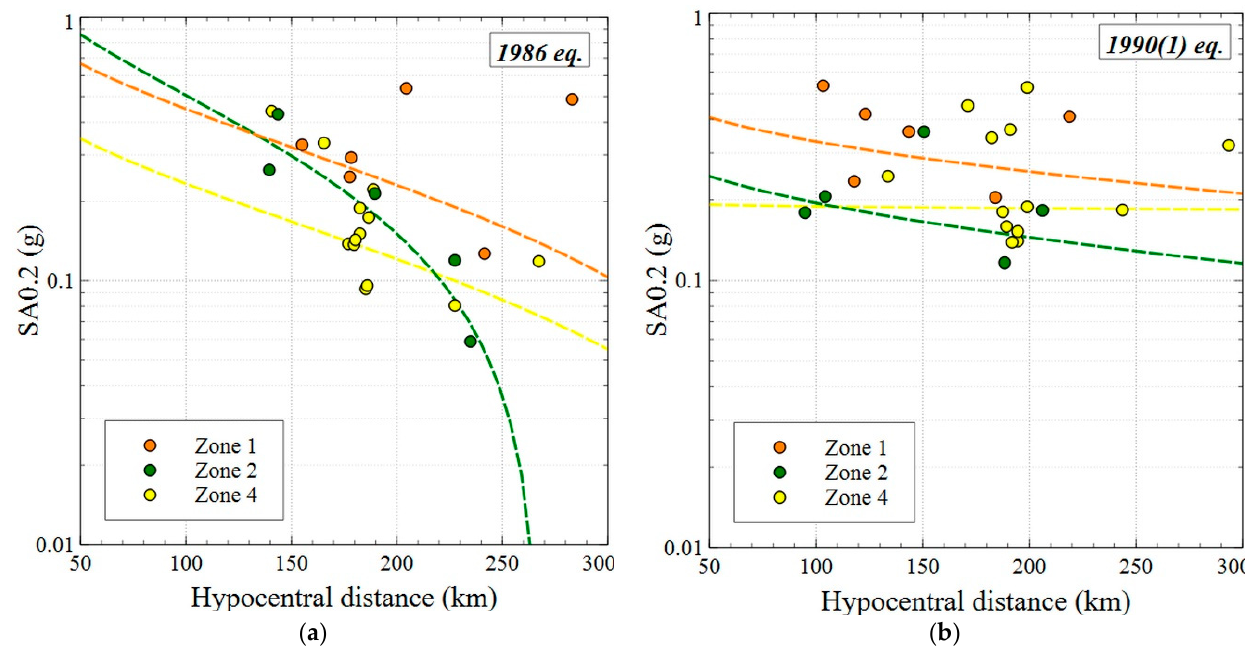
Figure 7. Comparison between the hypocentral distance attenuation curves for the spectral acceleration at 0.2 s for: (a) the 1986 Vrancea earthquake; (b) the 1990(1) Vrancea earthquake. With dashed lines are shown the corresponding logarithmic fit curves.